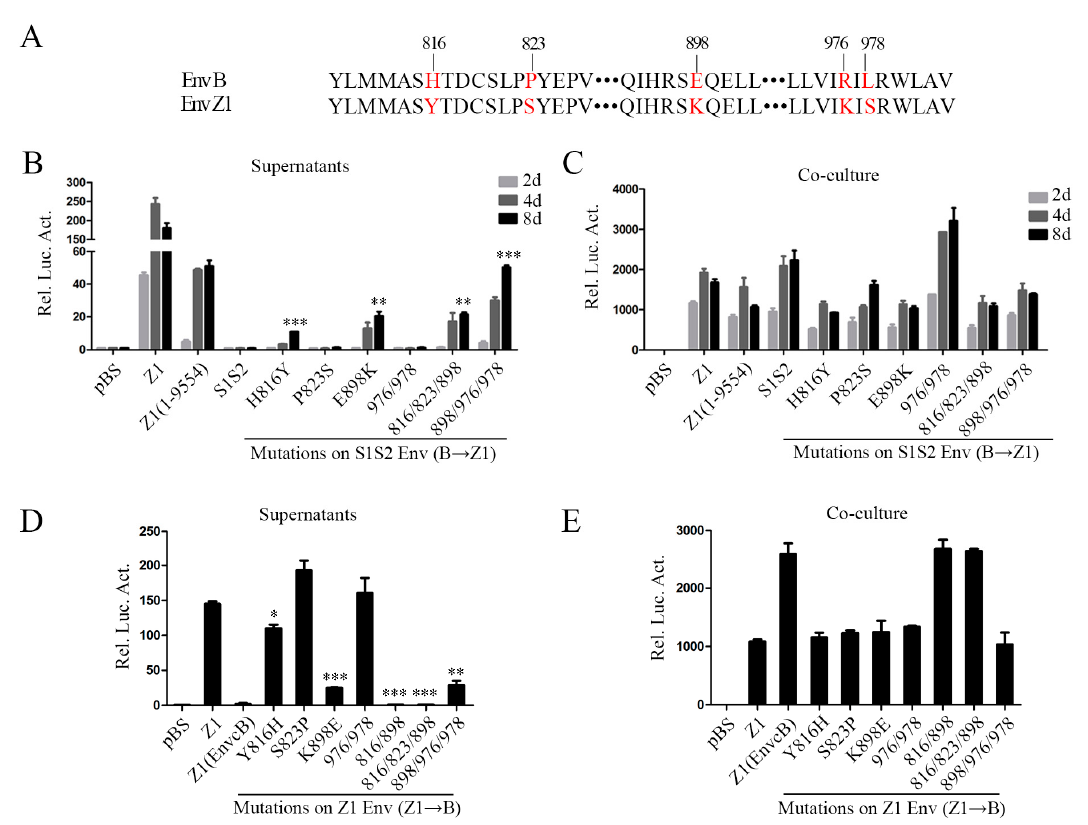
Figure 4. K898 in the env gene of BFV-Z1 is crucial for BFV cell-free transmission. ( A ) Amino acid site mutations, marked in red, in the C terminus of Env by sequence alignment analyses are shown. ( B , C ) Construction of infectious clones with point mutations on the basis of pBS-BFV-S1S2 from B to Z1 and their transfection to BHK-21 cells. The transmission activity was analyzed by measuring luciferase activity, and the data were the averages of three independent experiments. Compared with BFV-S1S2, * p < 0.05, ** p < 0.01, *** p < 0.001, **** p < 0.0001. ( D , E ) Construction of clones with point mutations based on pBS-BFV-Z1 from Z1 to B. Then, these were transfected into BHK-21 cells and the transmission activity was analyzed. Compared with BFV-Z1, * p < 0.05, ** p < 0.01, *** p < 0.001, **** p < 0.0001. “ ㆍ ” stands for omission.